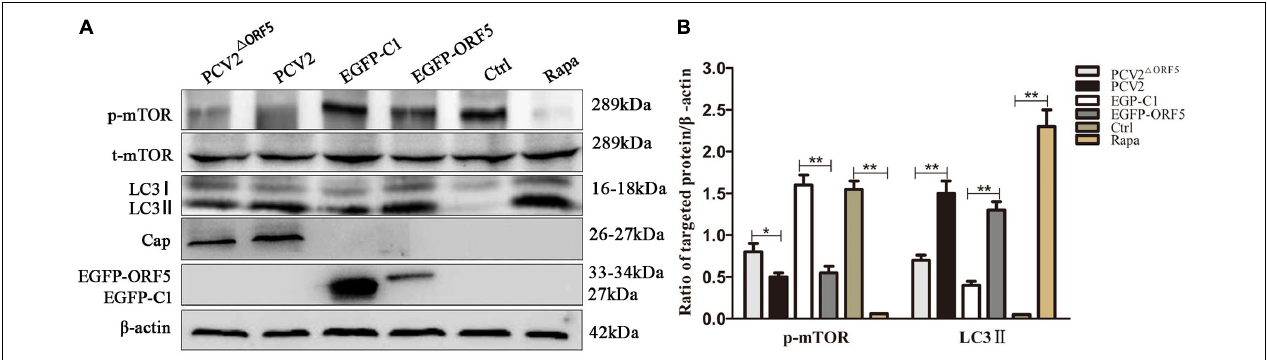
FIGURE 3 | ORF5 protein downregulates phosphorylation of mTOR. (A) PK-15 cells were transfected with EGFP-C1 (vector control) or EGFP-ORF5 for 48 h, infected with PCV2 or PCV2 (cid:49) ORF5 for 36 h. p-mTOR, t-mTOR, LC3II were detected by immunoblotting. (B) T -test on the grayscale analysis of the (A) picture, the ratio of targeted protein to β -actin. * p < 0.05, ** p < 0.01.